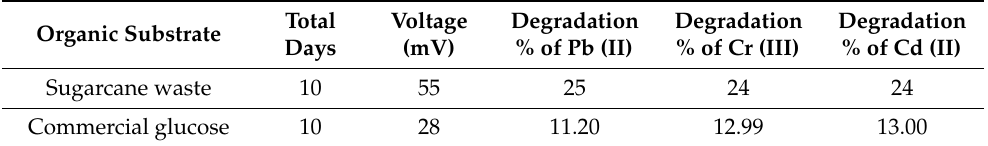
Table 5. Sugarcane and glucose as substrate performance in